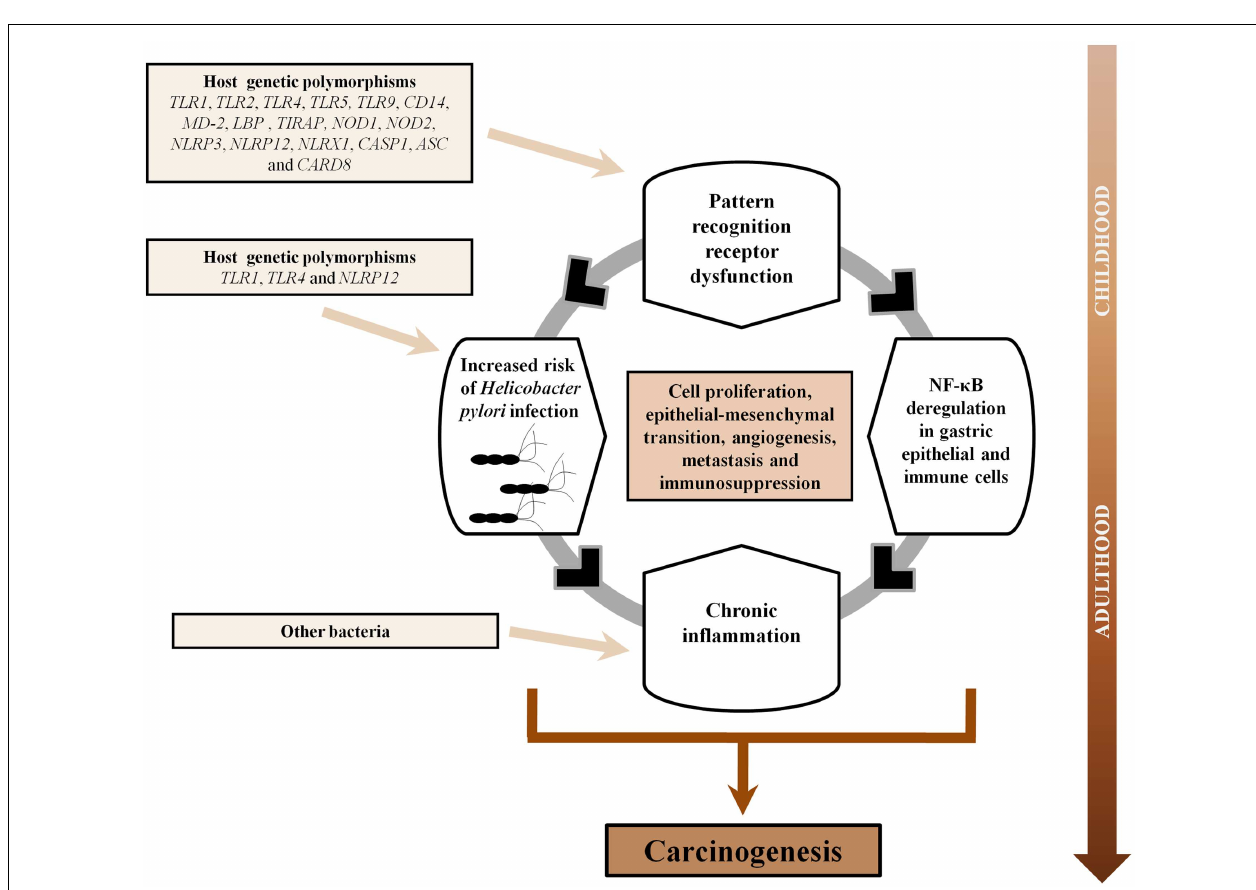
turn would impact upon the direction and magnitude of the chronic inflammatory response to H. pylori . As H. pylori , the dominant bacterium in the stomach, gradually disappears upon the development of gastric atrophy, it is plausible that other microbial species might bloom in its absence and perpetuate local inflammation through further PRRs activation. Over time, the combination of these events would facilitate a number of features that promote gastric cancer development including cell proliferation, epithelial–mesenchymal transition, angiogenesis, metastasis, and